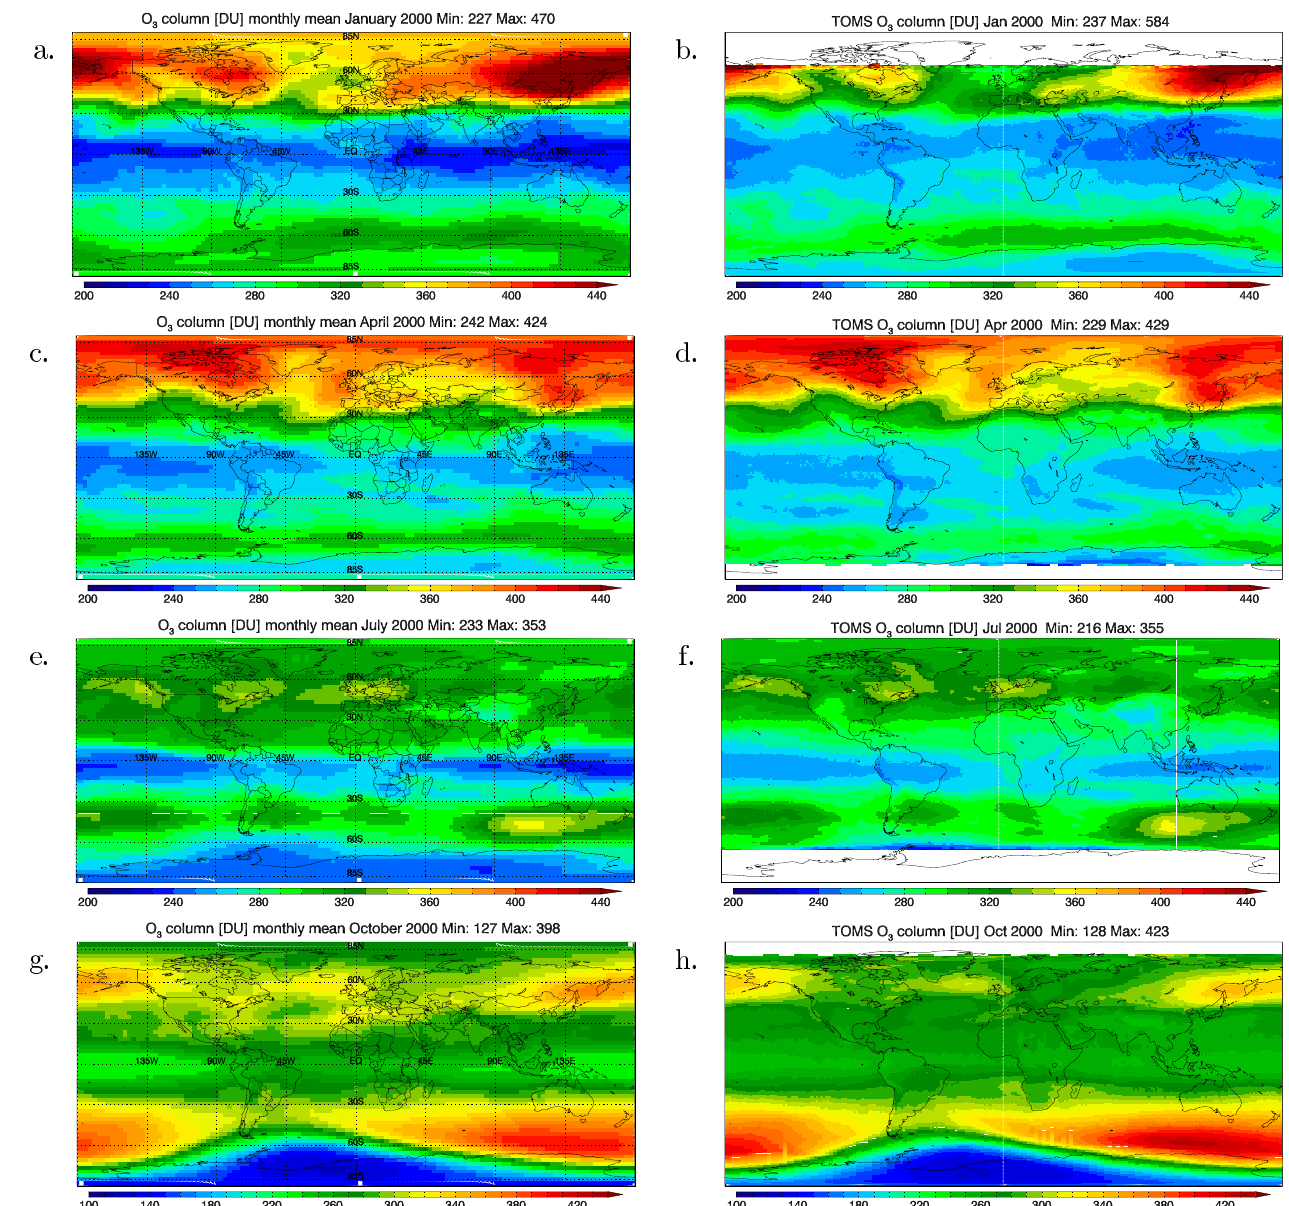
Fig. 5. The monthly mean total column of O 3 from run R2 2000, for July 2000. Note the different scale in October.